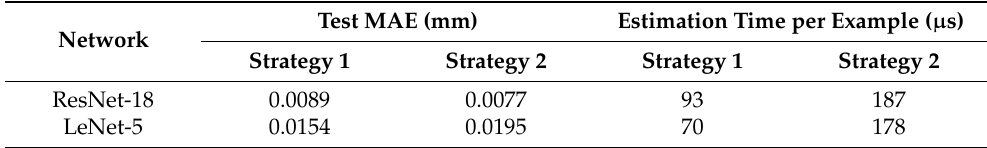
Table 2. Comparison between LeNet-5 and